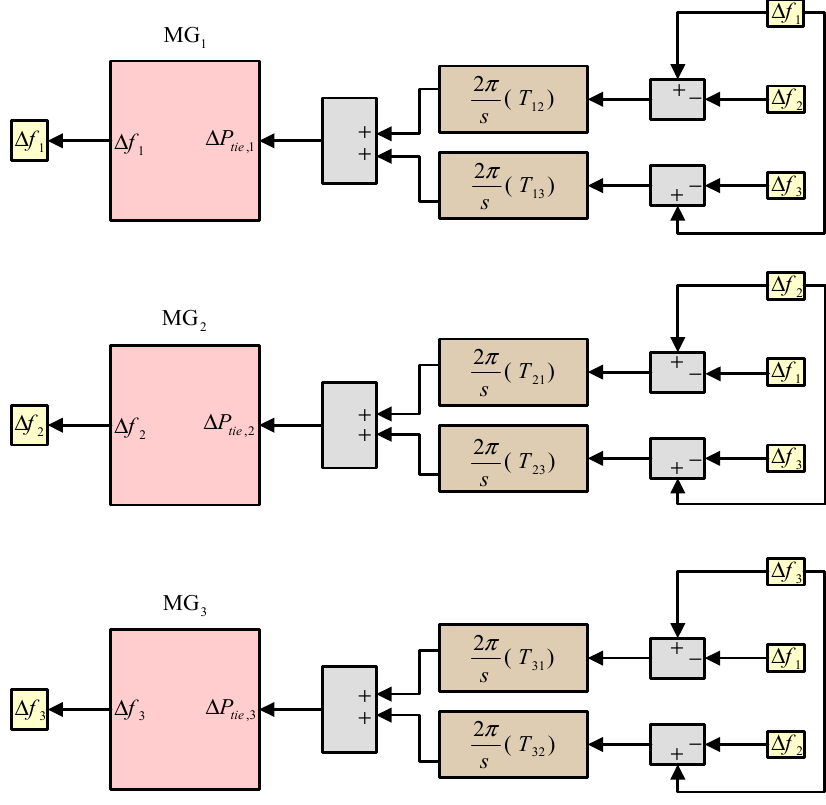
Figure 5. Dynamic model of the multiple microgrid clusters.